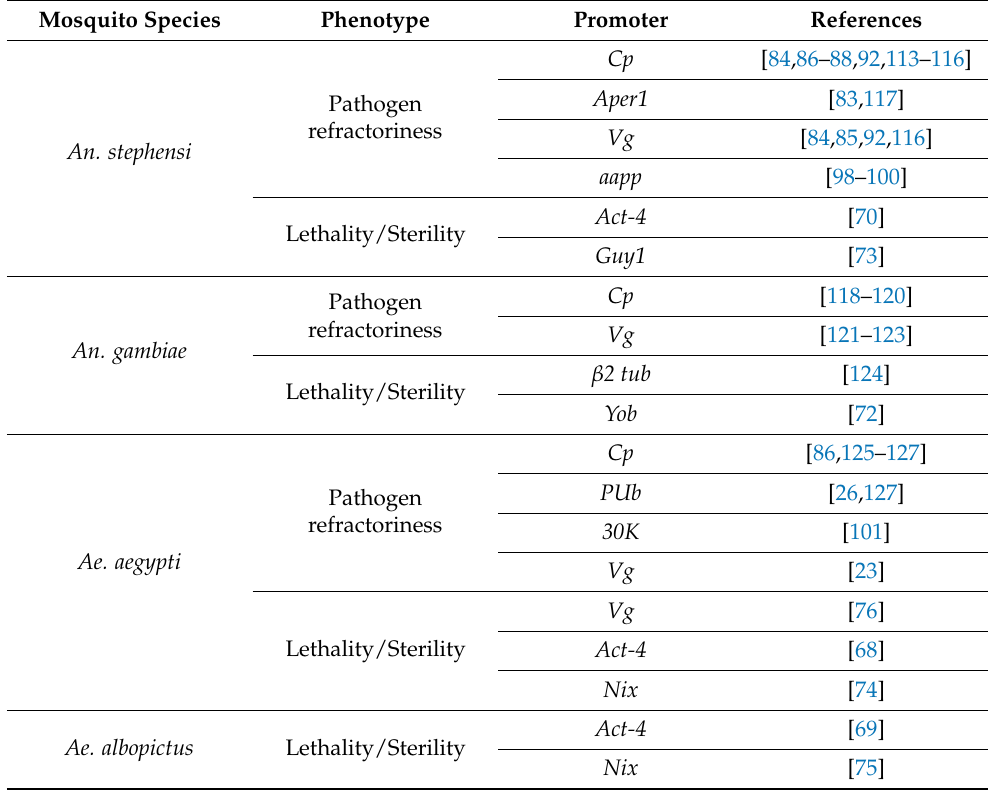
Table 1. Transgenic mosquitoes exhibiting pathogen refractoriness or lethal/sterile